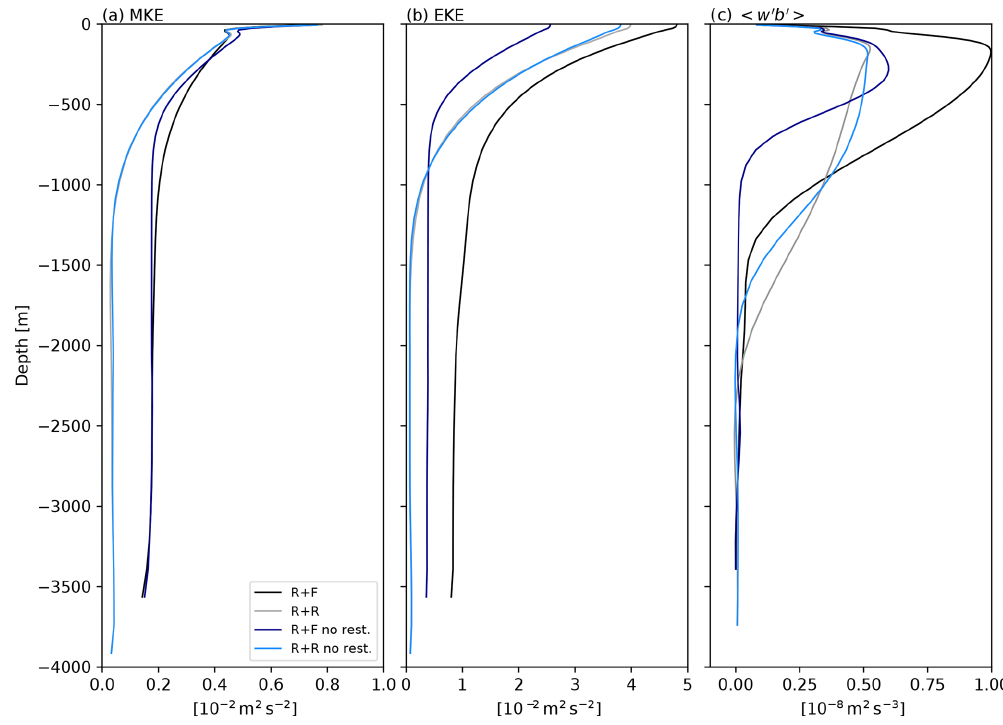
Figure 4. Vertical profile of (a) kinetic energy of the mean flow (m 2 s − 2 ) , (b) eddy kinetic energy (m 2 s − 2 ) and (c) < w (cid:48) b (cid:48) > the vertical eddy buoyancy flux (m 2 s − 3 ) as a signature of baroclinic energy transfer from eddy potential energy to eddy kinetic energy. Diagnostics use the last 10 years of the simulations and were averaged over the full domain in the zonal direction and between y = 500km and y = 1500km in the meridional direction. The velocity ( u (cid:48) , v (cid:48) , w (cid:48) ) and buoyancy ( b (cid:48) ) anomalies use to compute the eddy kinetic energy in (a) and the buoyancy flux in (c) are anomalies with respect to the 10-year temporal mean. The kinetic energy of the mean flow (MKE; a ) is computed using 10-year-averaged